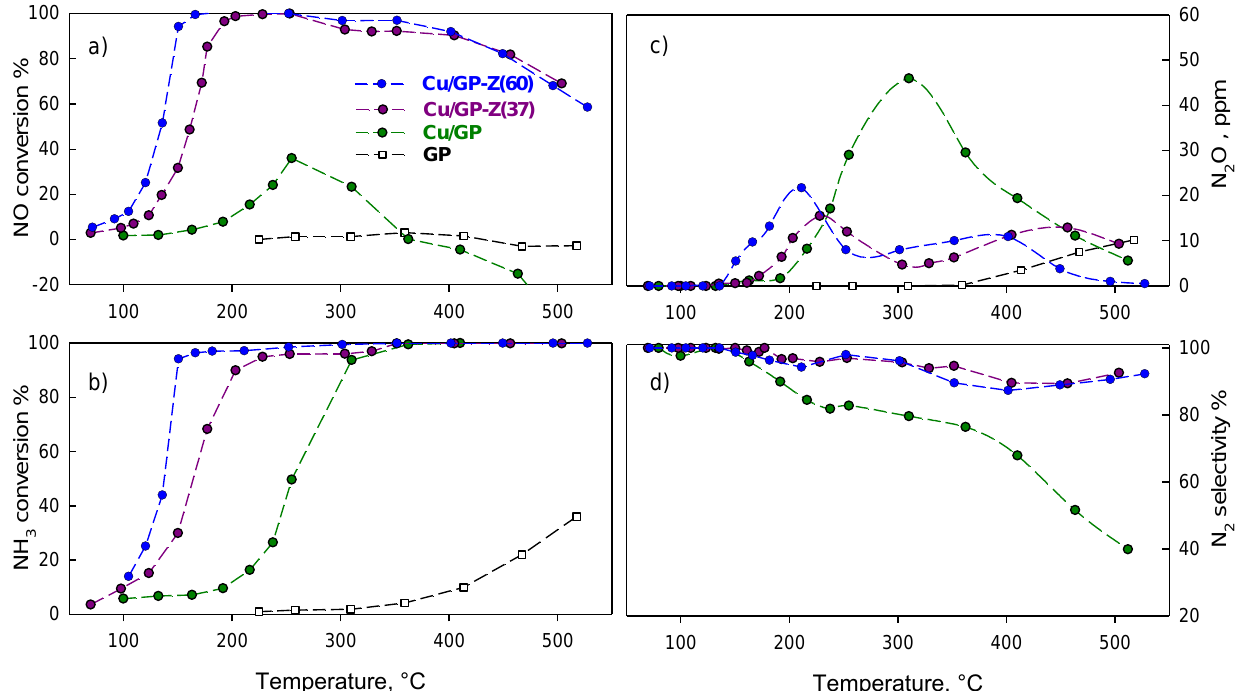
Figure 6. NO ( a ) and NH 3 ( b ) conversion, N 2 O production ( c ) and N 2 selectivity ( d ) as a function of the reaction temperature during the NH 3 -SCR of NO over GP and Cu/GP-Z(x) exchanged monoliths.